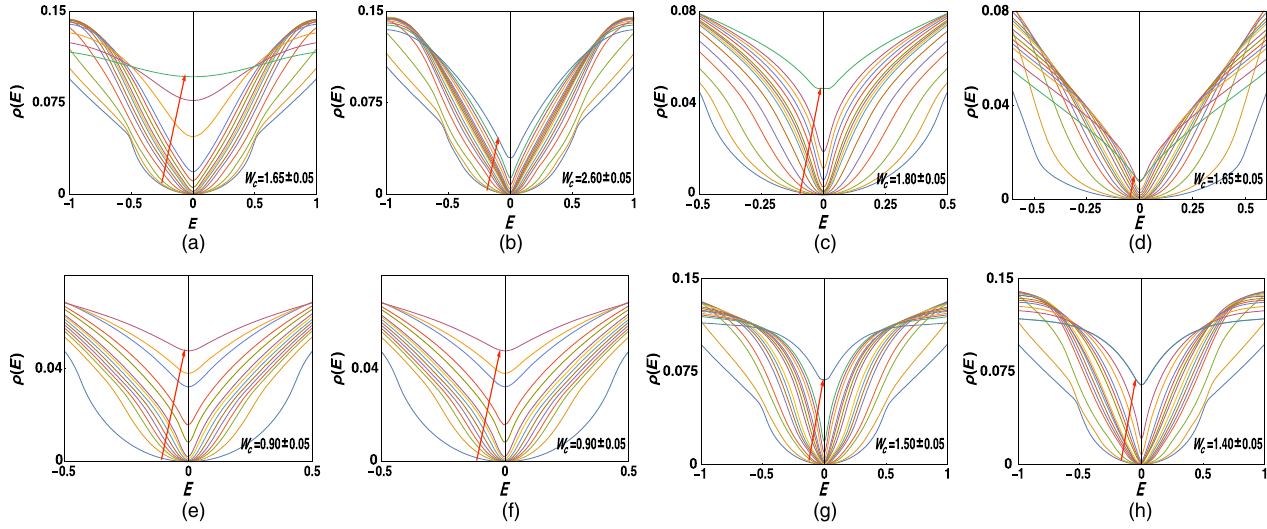
FIG. 3. Scaling of numerically evaluated (using the kernel polynomial method [72]) average density of states in dirty Weyl semimetals in the presence of (a) potential, (b) axial, (c) axial current, (d) current, (e) spin-orbit (represented by temporal component of tensor), (f) axial magnetic (represented by spatial component of tensor), (g) scalar mass, and (h) pseudoscalar mass disorder for weak to strong disorder regime, in a cubic lattice of linear dimension L ¼ 220 (see Table III for definition and field-theoretic nomenclature). Notice that for weak enough disorder, ADOS ϱ ð E Þ ∼ j E j 2 for j E j ≪ 1 . In the metallic phase, appearing for strong enough disorder, ADOS at zero energy ϱ ð 0 Þ becomes finite. Around a (nonuniversal) critical strength of disorder W ¼ W the ADOS scales as ϱ ð E Þ ∼ j E j for j E j ≪ 1 . c Since ϱ ð E Þ ∼ j E j d=z − 1 , the dynamic scaling exponent z ≈ 1 . 5 across the WSM-metal quantum phase transitions, irrespective of the nature of the elastic scatterers. Disorders in (a) – (d) preserve the emergent global chiral symmetry and represent intranode scattering, while the remaining ones [(e) – (h)] break that symmetry and represent internode scattering. Numerically extracted critical exponents across WSM-metal QPTs and their comparison with the field-theoretic predictions are displayed in Tables I and II, suggesting an excellent agreement between these two methods and emergence of a superuniversality across WSM-metal QPT. The strength of disorder increases monotonically in the direction of the red arrow in each